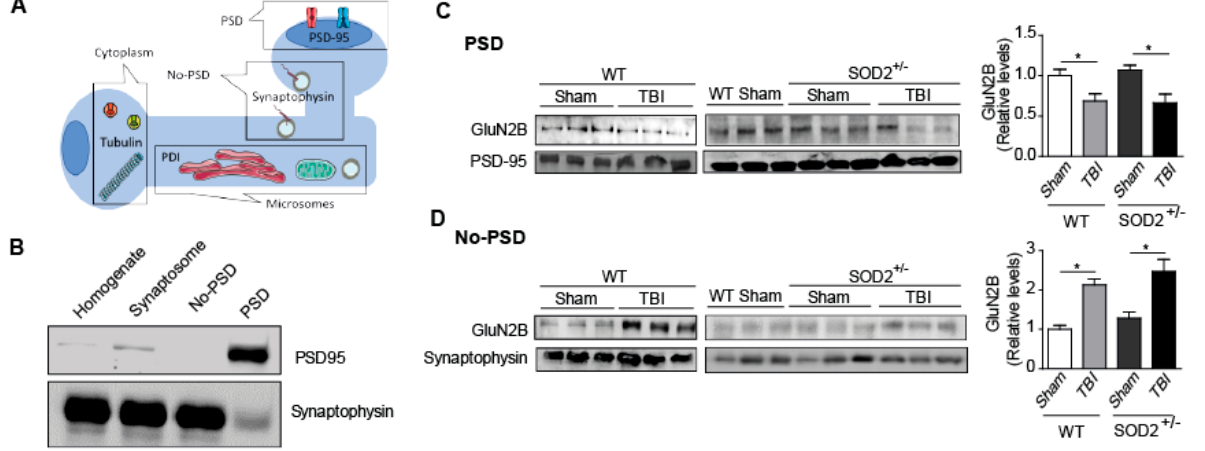
Figure 4. WT and SOD2 +/- mice showed failure in NMDA synaptic response and NMDA subunit phosphorylated status after TBI. ( A) . fEPSP slope induced by the input-output protocol to record responses corresponding to NMDARs from WT and SOD2 +/- mice after TBI. ( B) . Immunoblot analyses of phosphorylated GluN2B subunits of NMDARs and densitometric analysis of tyrosine 1472 and tyrosine 1336 phosphorylation in hippocampi lysates from WT and SOD2 +/- mice after TBI. Three animals were used per experimental group. 3-4 hippocampal slices per animal were analyzed Statistically significant differences were calculated by one-way or two-way ANOVA, followed by Bonferroni’s post hoc test. Symbols indicate the statistical significance of the observed differences. (Figure 4A: θθ p ˂ 0.01; between WT Sham and WT TBI; φφφ p ˂ 0.001 between SOD2+/- Sham and SOD2 +/- TBI; *** p ˂ 0.001 between WT TBI and SOD2 +/- TBI. Figure 4B: * p ˂ 0.05, n.s.: non- significant).